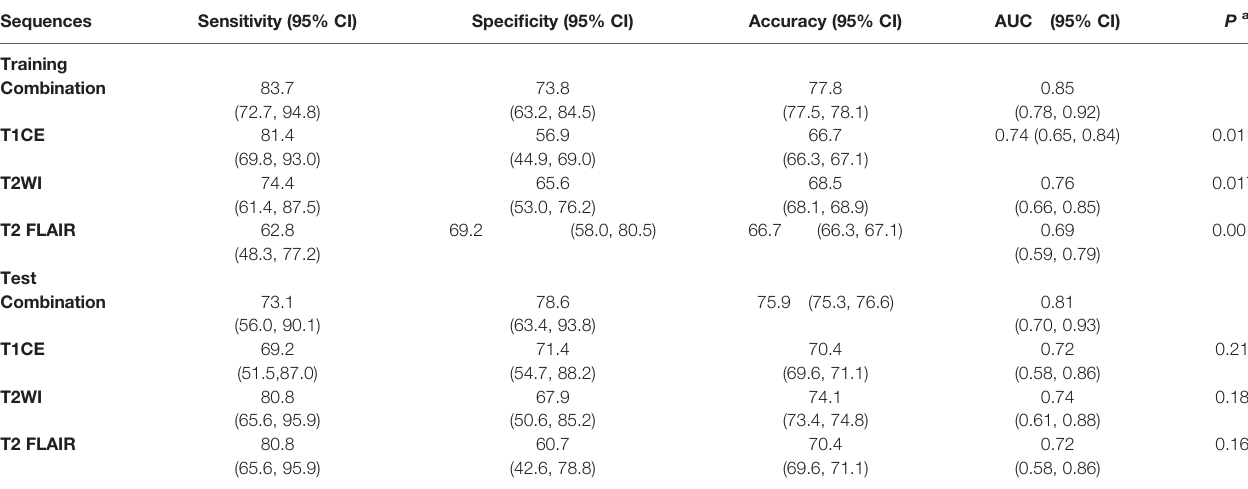
TABLE 3 | The performance of radiomics in predicting EGFR mutation status in various